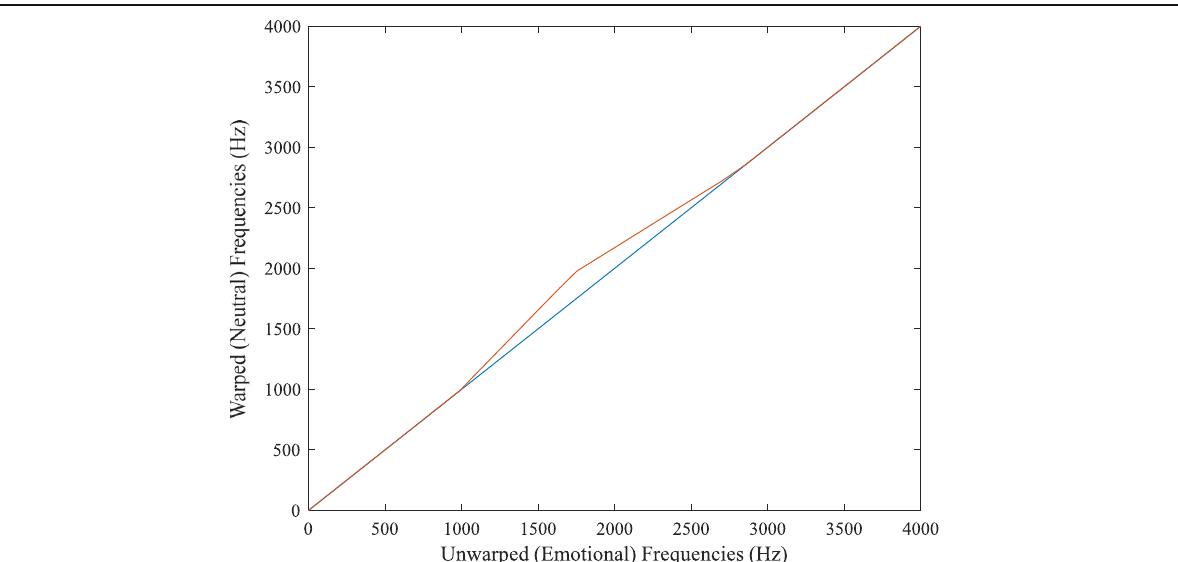
Fig. 4 The piecewise linear frequency warping function obtained for a sample utterance of Disgust in the Persian ESD database [17], with the warping factor α = 1.3, f 2 l = 982, f 2 h = 1739, and f 3 h =